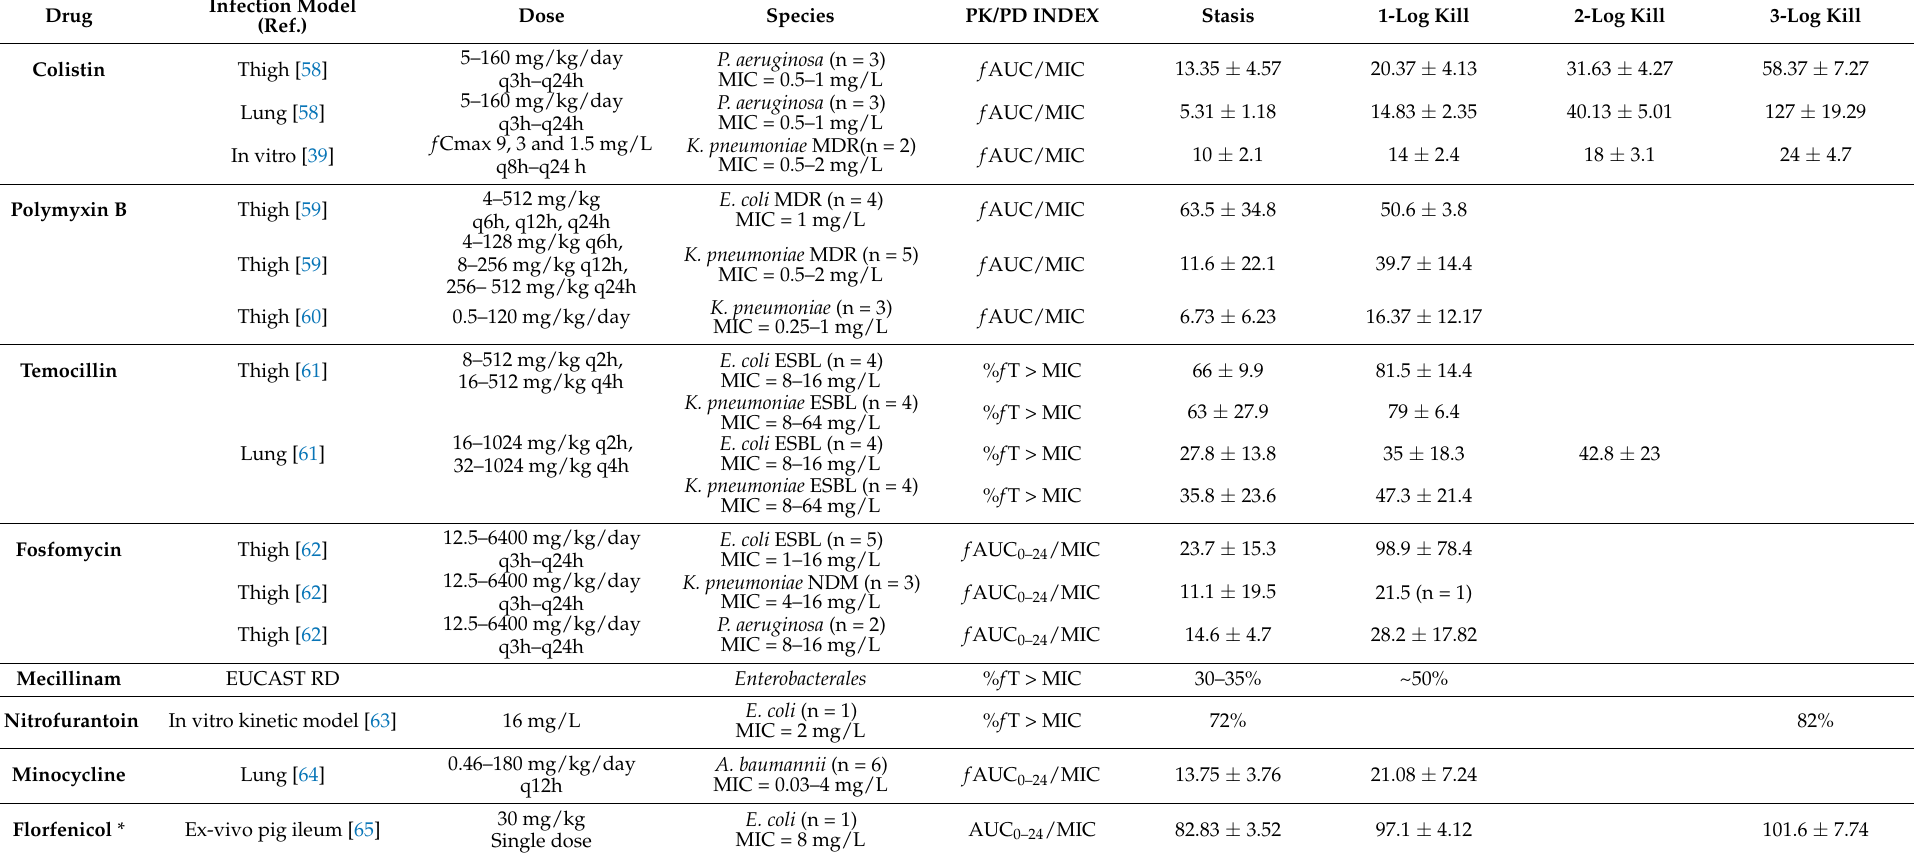
Table 3. Plasma PK/PD target (mean ± SD) for old